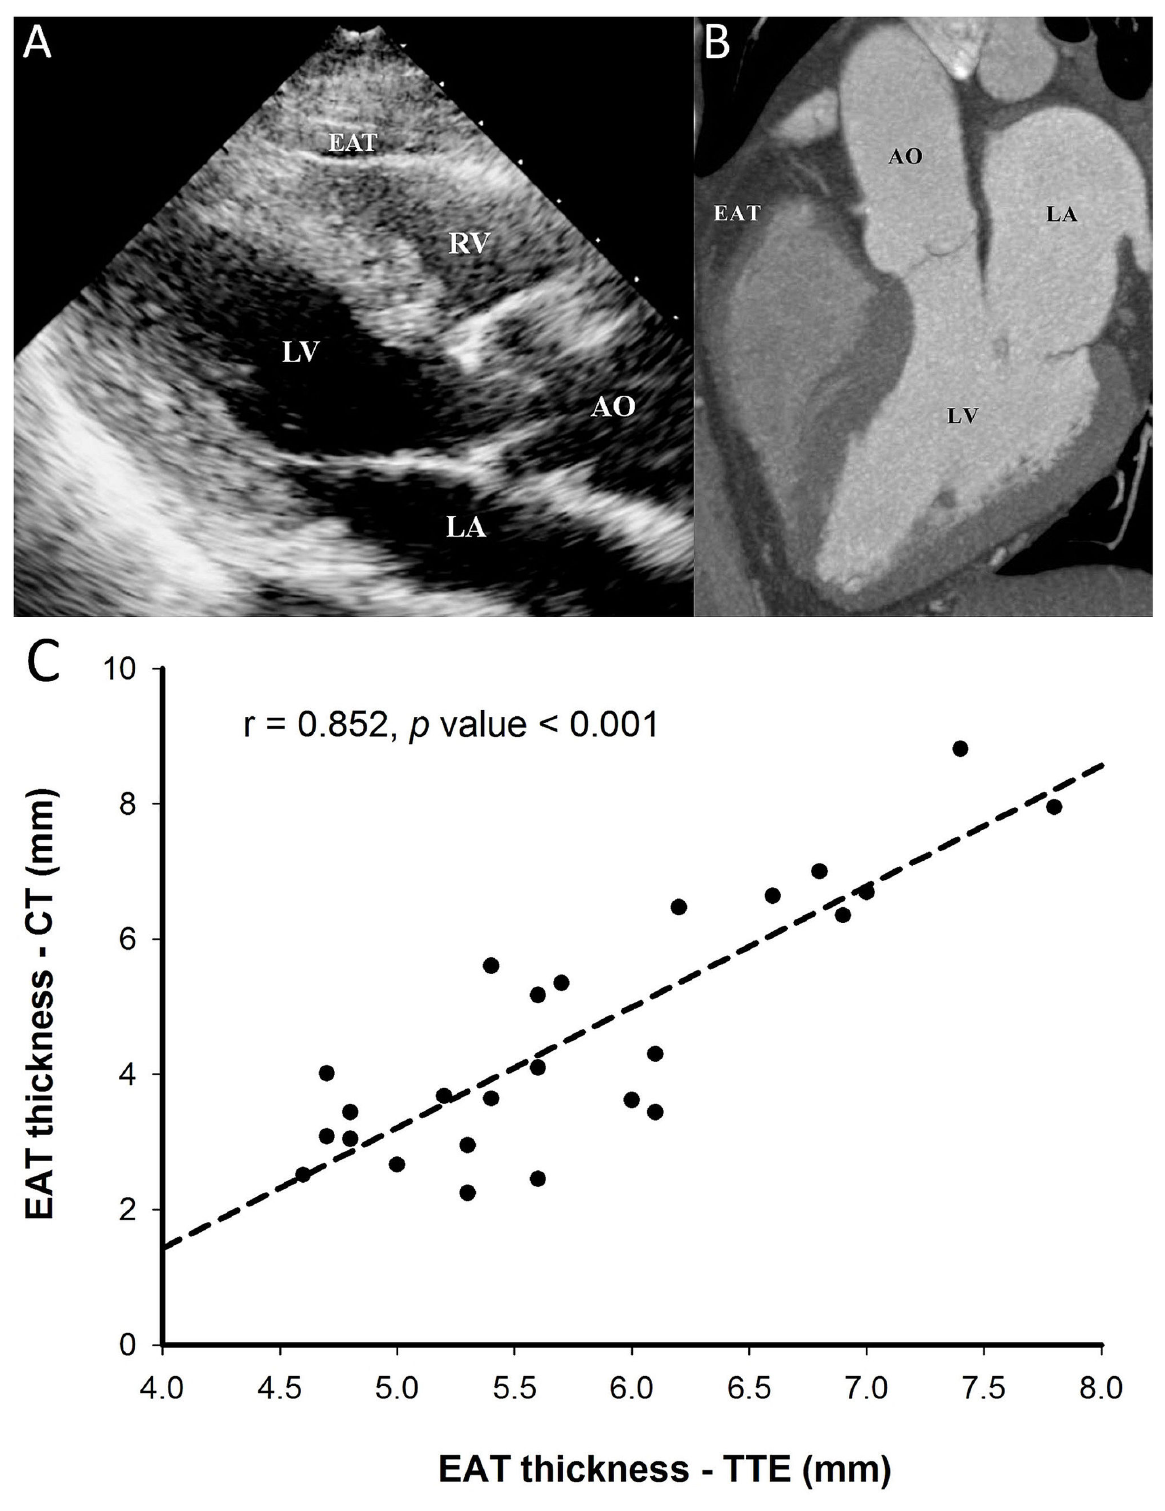
Figure 1. Measurement of EAT. The thickness of EAT measured in parasternal long-axis view of TTE (A) and 3-chamber view of CT with contrast enhancement (B) showed significant correlation (C). AO = aorta; CT = computed tomography; EAT = epicardial adipose tissue; LA = left atrium; LV = left ventricle; RV = right ventricle; TTE = transthoracic echocardiography. doi: 10.1371/journal.pone.0074926.g001 PLOS ONE |